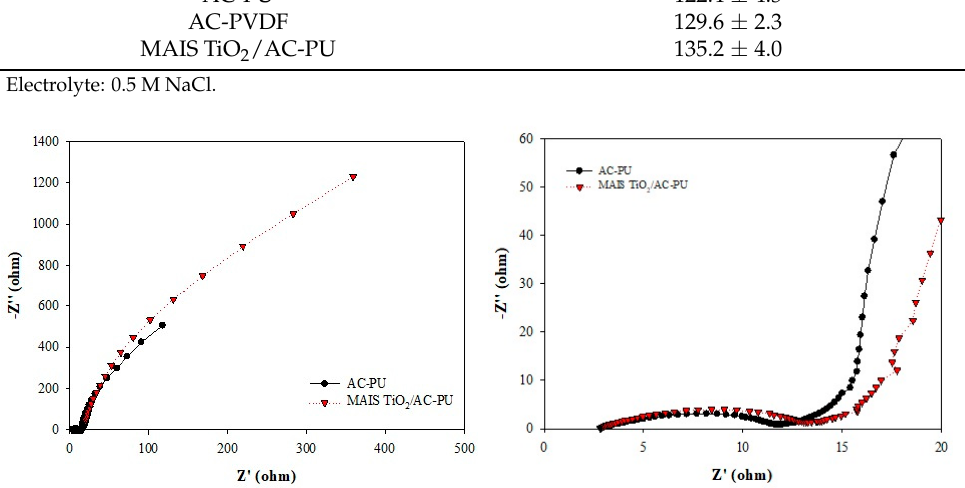
Figure 3. Nyquist plots for the electrodes: left is whole region; right is close-up of the near region.